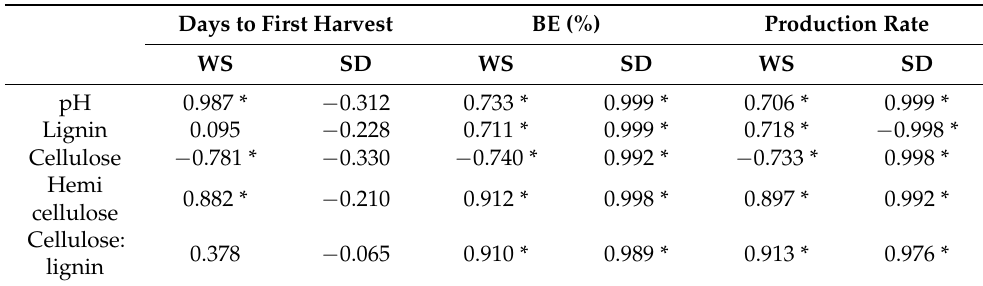
Table 4. Correlation between percent changes in the lignocellulosic composition of the substrates and the BE of shiitake mushroom